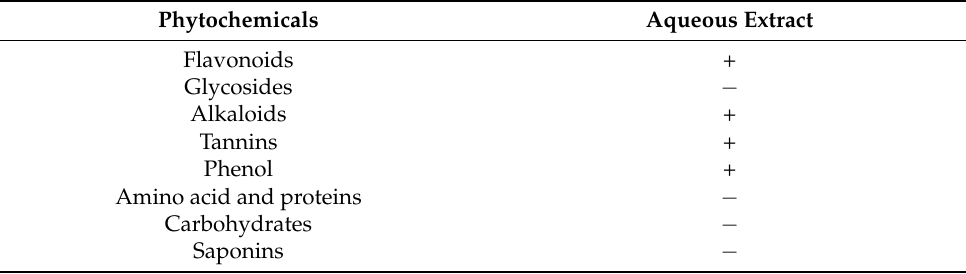
Table 1. Qualitative phytochemical screening of aqueous leaf extract of R. sativus .